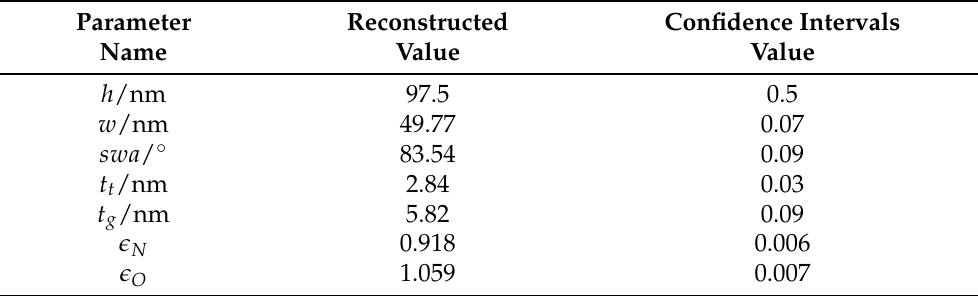
Figure 4. Comparison of the measured and simulated fluorescence maps for N-K α ( a ) and O-K α ( b ) based on the reconstructed parameter set. ( c ) Comparison of the experimental N-K α (green) or O-K α (blue points) fluorescence intensities for ϕ = 0 ◦ to the reconstructions from the Bayesian optimization (red lines). Table 2. The values of the geometrical parameters of the nanostructures from the GIXRF BO recon- struction with the model parameter confidence intervals (one sigma). The parameters are height h , width w , sidewall angle swa , oxide layer in the groove t g , and oxide layer on the grating line t t